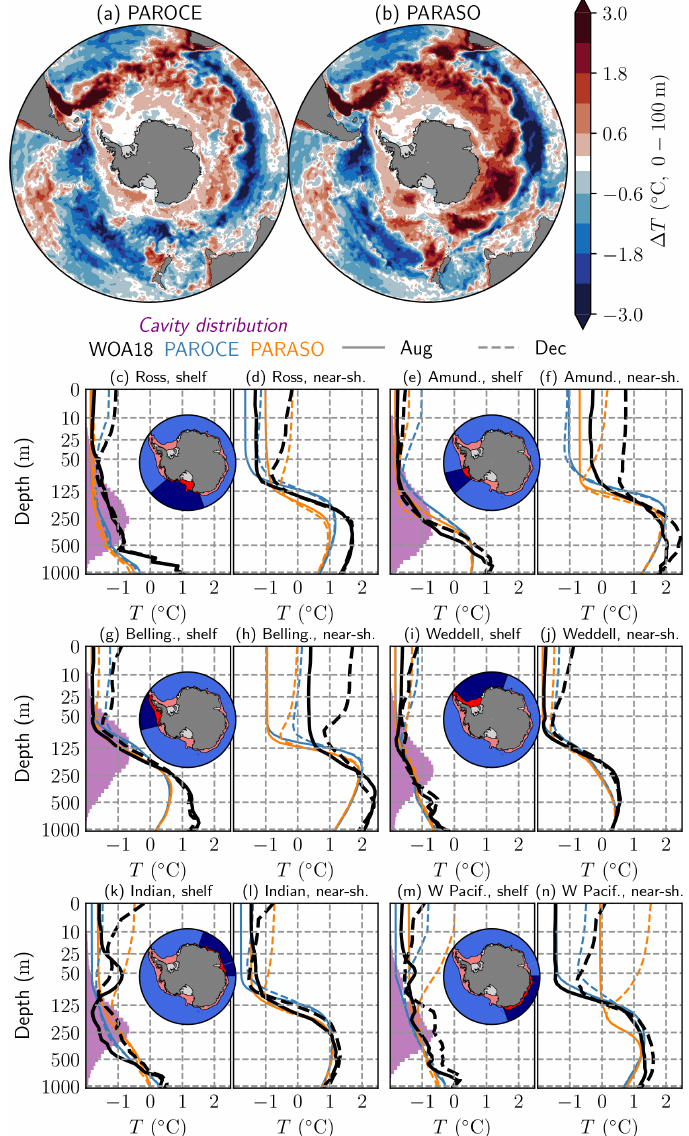
Figure 9. (a–b) In situ temperature biases for (a) PAROCE and (b) PARASO, with respect to the World Ocean Atlas 2018 (WOA18), averaged on the top 100m of the ocean and the full seasonal cycle. (c–n) In situ temperature vertical profiles for WOA18, PAROCE and PARASO, in August (full) and December (dashed), over six circumpolar basins drawn on indicative maps. Note the nonlinear z axis. On the indicative maps, bright red shadings indicate the continental shelf (defined by the 1200m isobath; see panels c , e , g , i , k , m ); dark blue shadings indicate the “near-shelf” area (see panels d , f , h , j , l , n ), defined as the area outside of the continental shelf and south of 60 ◦ S. On the continental shelf vertical profile panels (c, e, g, i, k, m) , the purple shadings represent each sector’s vertical distribution of ice-shelf cavity presence (i.e., sector-specific, horizontally integrated area of ice-shelf-cavity–open-ocean interfaces, in normalized units). For WOA18, the data are taken from a 1995–2004 climatology; for PAROCE and PARASO, they are taken from simulation outputs for the year 2001 (second simulated